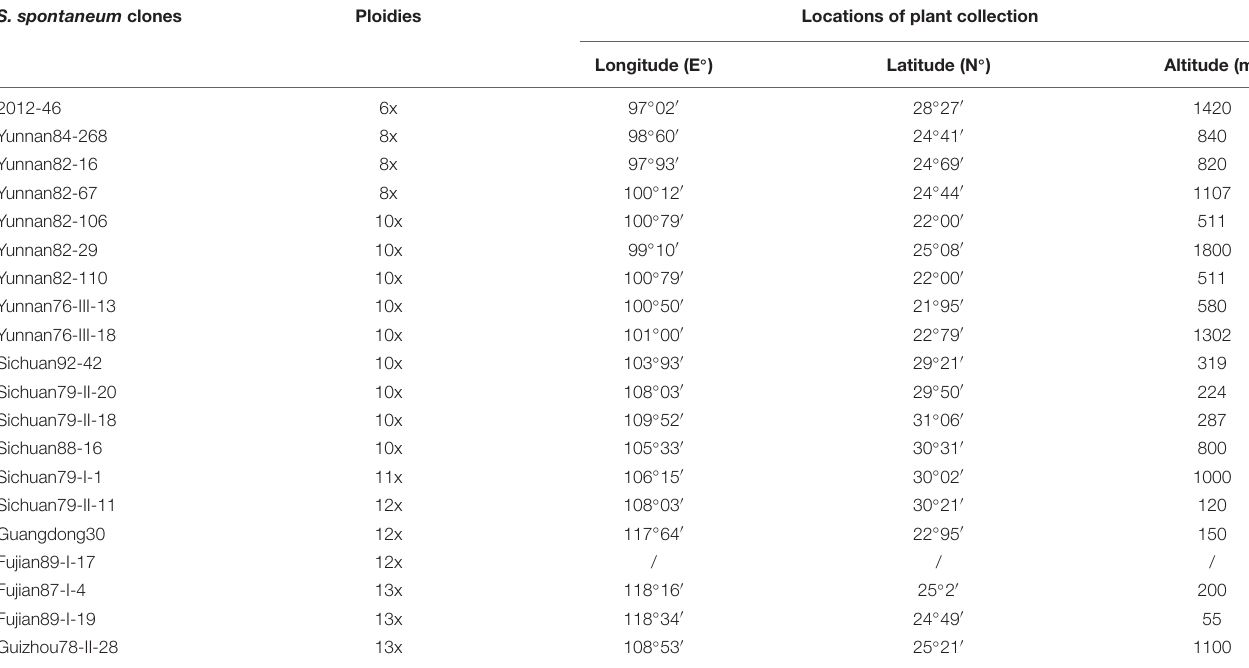
TABLE 1 | The ploidies of S. spontaneum clones used in this study. S. spontaneum clones Ploidies